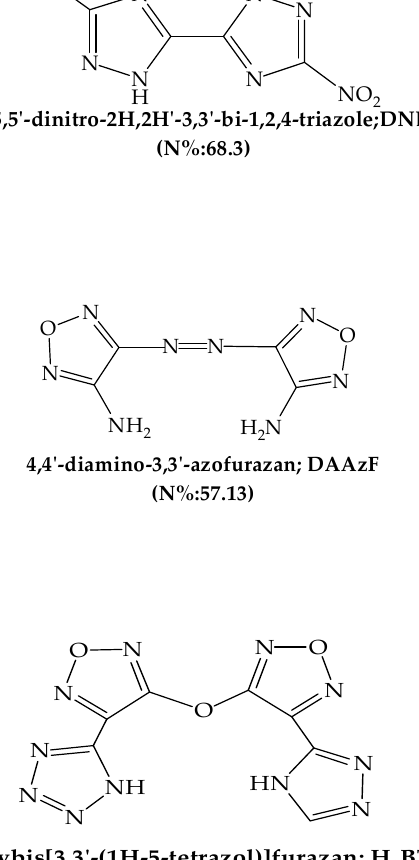
Figure 7. Nitrogen-rich heterocyclic compounds [54–76].